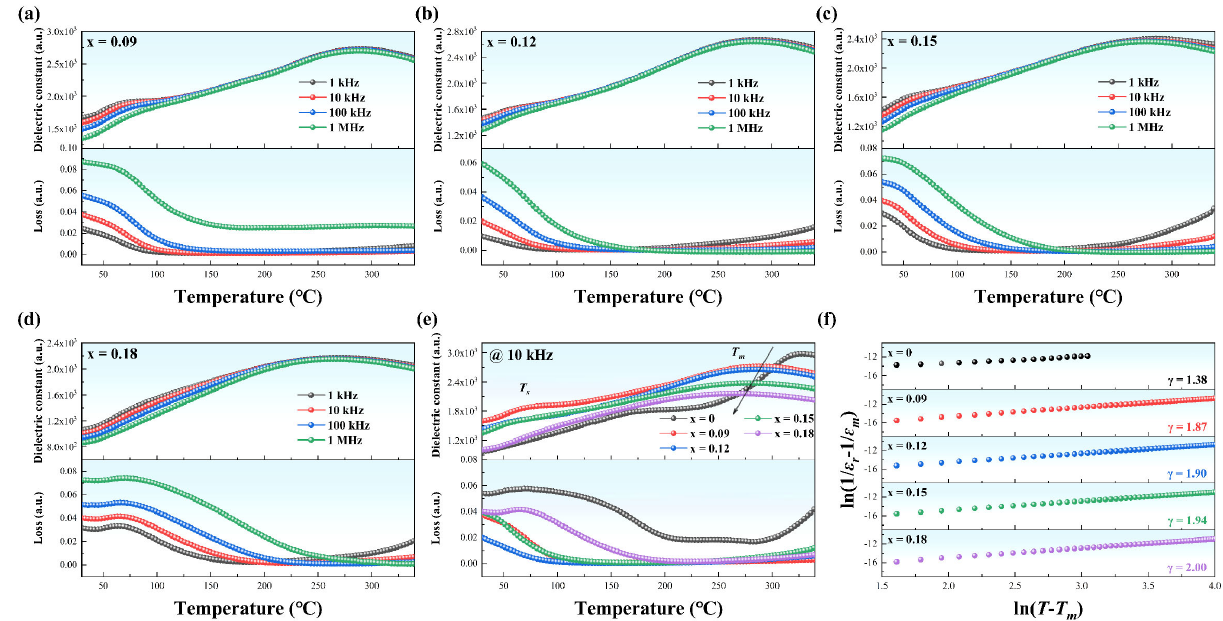
Figure 3. Temperature ‐ dependent dielectric properties for NBT ‐ SBT ‐ xBMZ ceramics in the tem ‐ perature range from 30 to 340 °C. ( a ) x = 0.09; ( b ) x = 0.12; ( c ) x = 0.15; ( d ) x = 0.18; ( e ) dielectric con ‐ stant and loss tangent as a function of temperature for various compositions at 10 kHz; ( f ) ln(1/ ε r − 1/ ε ) as a function of ln( T − T m ). as a function of ln( T − T m